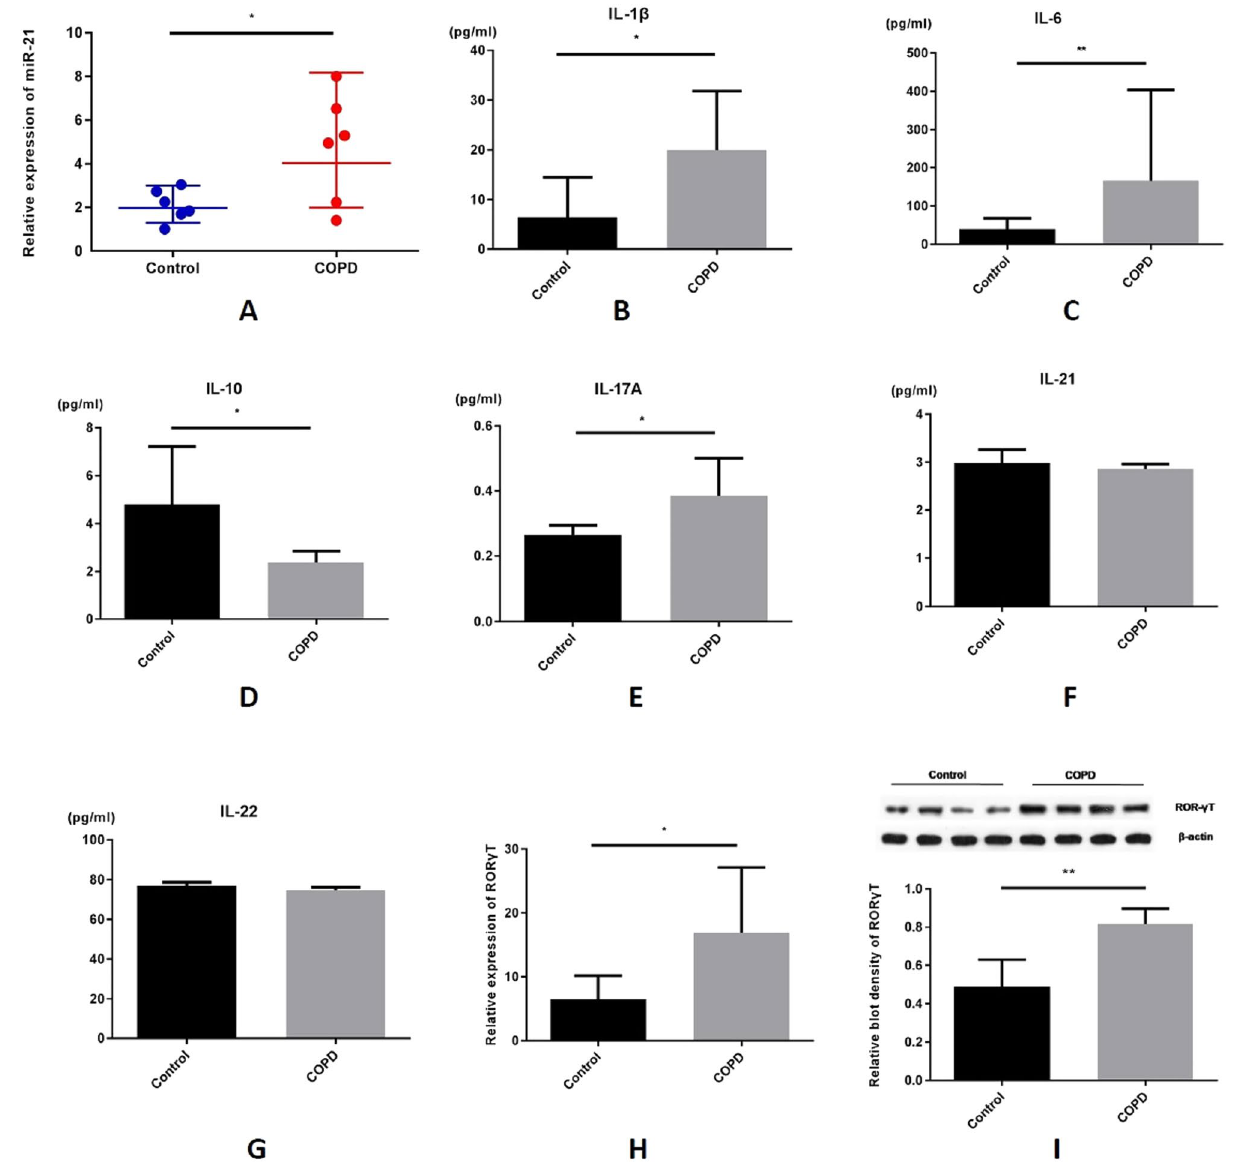
Figure 1. MiR-21 and Th-17 related cytokines levels increase in lungs of COPD patients. ( A ) COPD patients have a higher level of miR-21 in lungs. ( B )–( G ) Th17-related cytokines (IL-1β, IL-6, IL-10, IL-17A, IL-21, IL-22, respectively) are all increased in lungs of COPD patients. ( H ) The mRNA level of RORγT increases in lungs of COPD patients. ( I ) The protein level of RORγT increases in lungs of COPD patients. In western blot, different samples of the same marker are from the same blot. The data are expressed as the mean ± SEM (n = 6 in each group), t-test was applied in this part, *P <